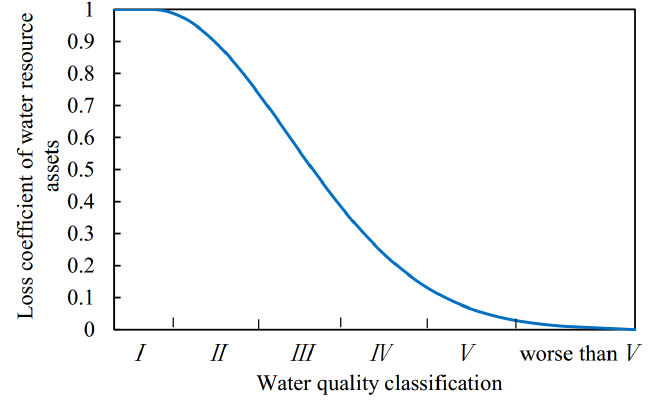
Figure 2. Loss coefficient of water resource assets and water quality